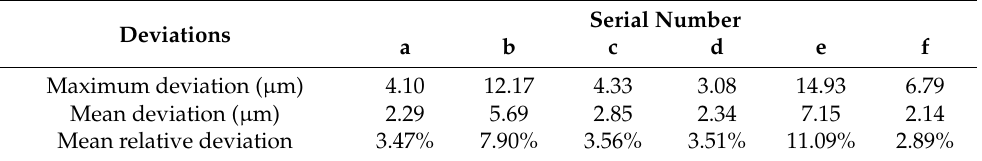
Table 6. Deviations of the microgroove profile between simulation and Exp.